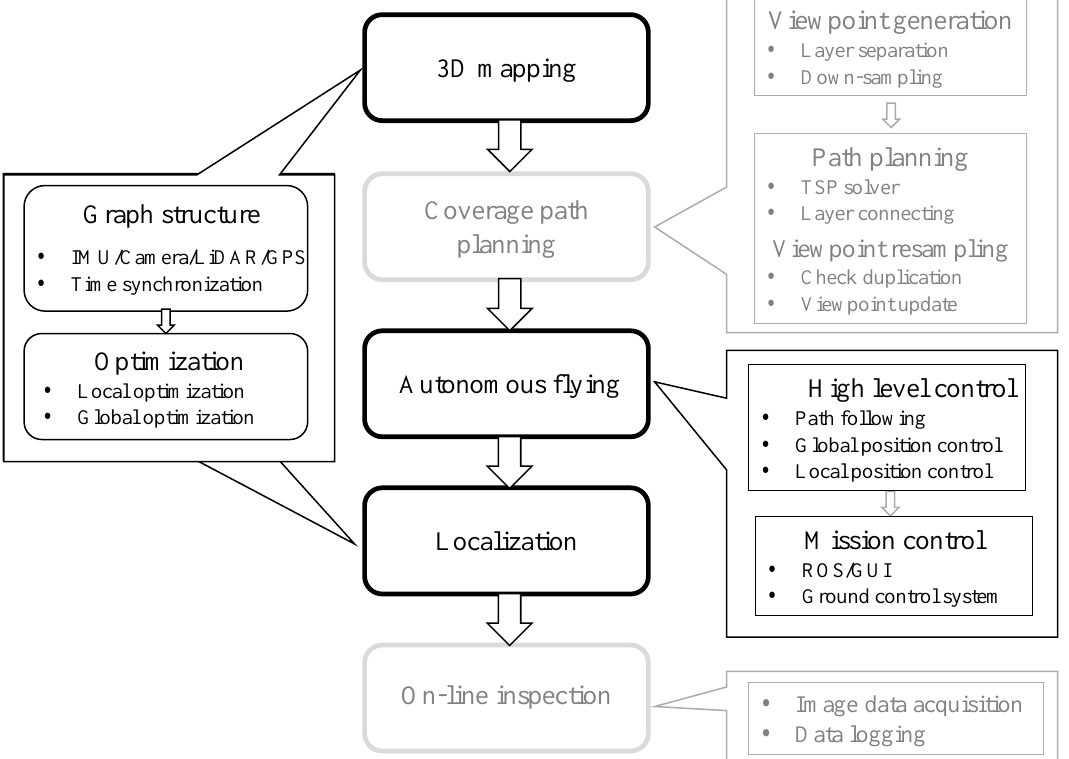
Figure 1. Overall framework for autonomous bridge inspection using a UAV (unmanned aerial vehicles). The first two stages, 3D mapping and coverage path planning, are preflight processes. After